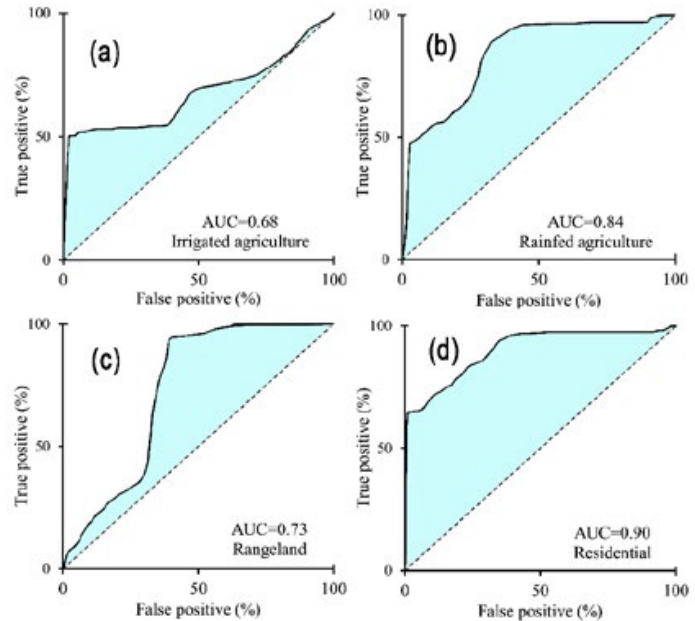
Fig. 8: ROC analysis results for CA-Markov simulation; (a) Irrigated agriculture, (b) Rainfed agriculture, (c) Rangeland, (d) Residential